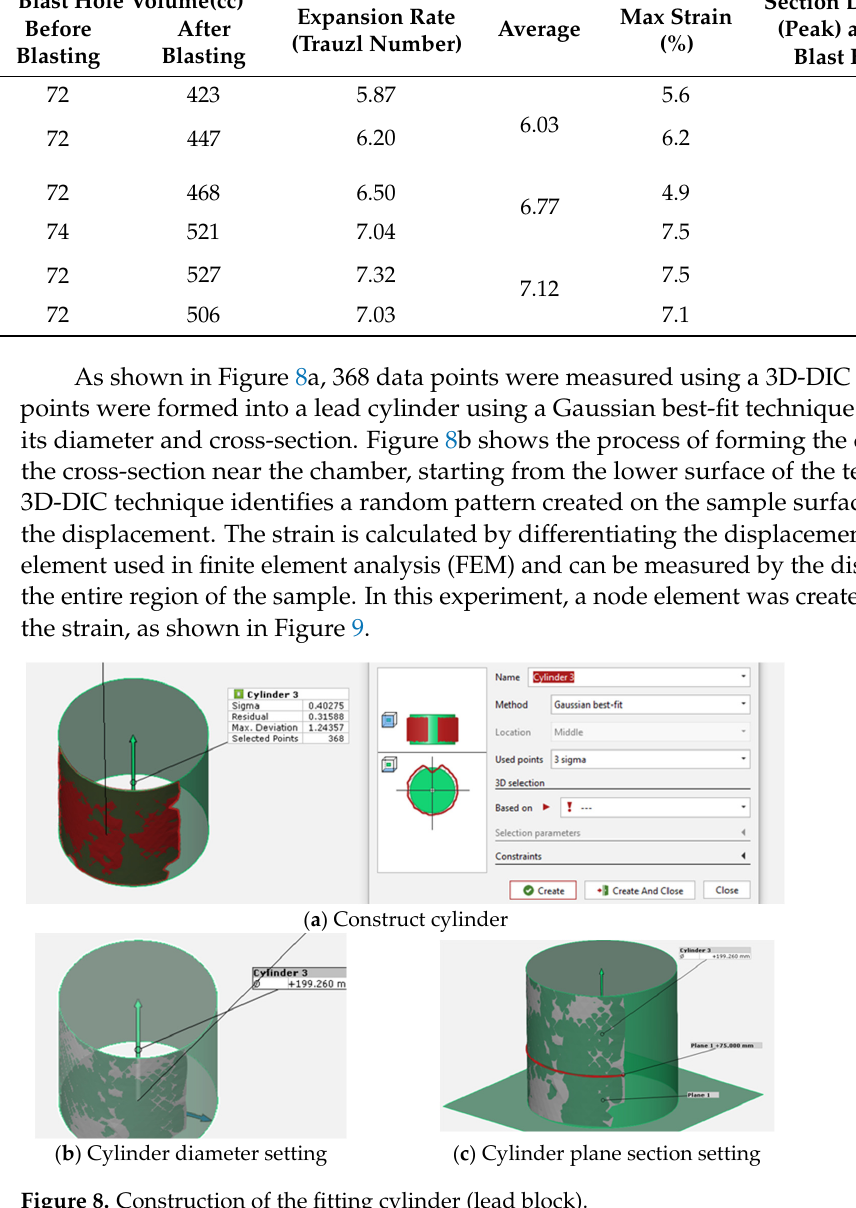
Figure 9. Calculation of the strain rate of the lead block using node element . The initial volume of the lead block blast hole before the explosive charge detonation was measured to be 72–74 cm 3 , and the average expansion rate of the lead block after the explosion, i.e., the average Trauzl number, of the STF ‐ based blasting stemming material was 7.12, higher than that of the fine aggregate (6.77) and sand (6.03). After estimating the blasting stemming effect of the STF ‐ based stemming material based on the lead block ex ‐ pansion of the sand, the STF ‐ based stemming material showed a stemming effect approx ‐ imately 18% higher than that of sand. Table 6 shows the displacements of each designated point on the lead block surface measured using the 3D ‐ DIC system, and these are the ini ‐ tial displacement data between the detonation of the explosive charge and the maximum expansion point of the lead block.